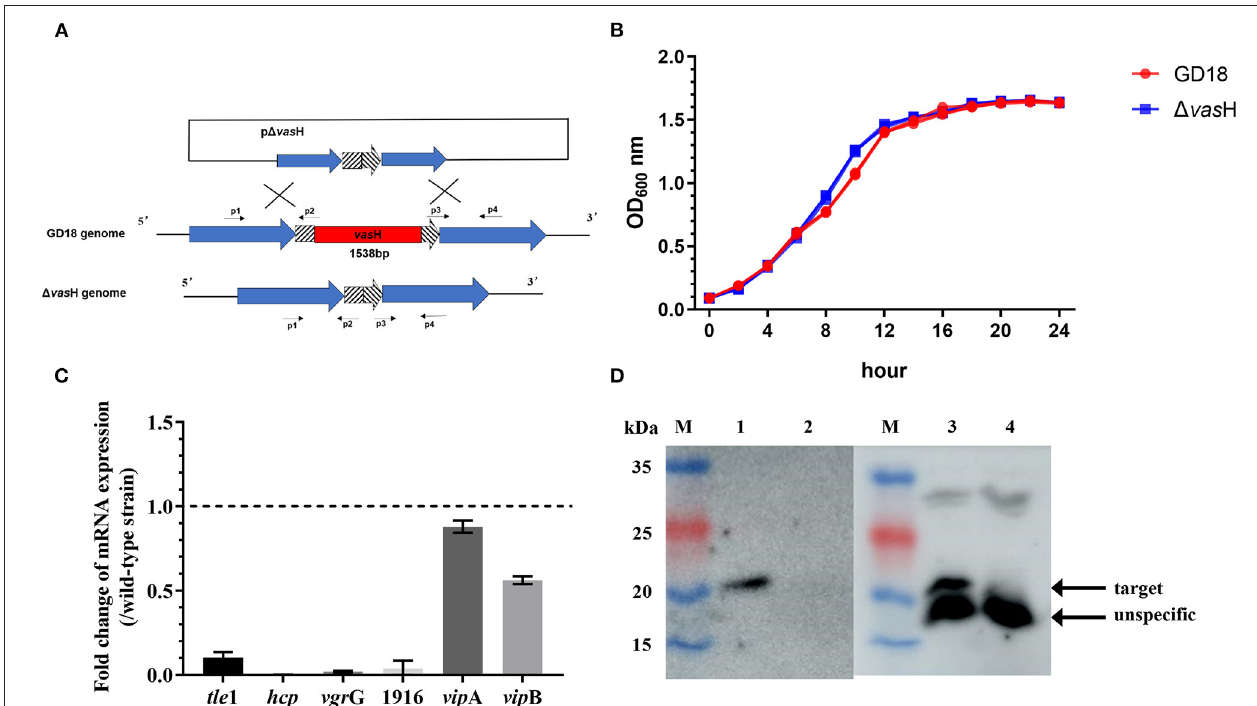
FIGURE 6 | Construction and phenotypic characterization of 1 vas H strain. (A) Construction strategy of 1 vas H by homologous recombination. (B) Growth curves in LB medium over a 24h period at 28 ◦ C. (C) Fold change of transcriptional levels of the T6SS genes in 1 vas H comparing to that in the wild-type strain at 28 ◦ C. The mRNA level of each gene was normalized to that of 16S rRNA. The data was presented as the mean ± SD of three independent experiments. (D) Hcp expression and secretion in whole-cell and supernatants of wild-type and mutant strains. Lane M, PageRuler prestained protein ladder; lane 1, GD18 supernatant; lane 2, 1 vas H supernatant; lane 3, GD18 whole-cell; lane 4, 1 vas H whole-cell. The data was from one representative experiment with at least three independent biological replicates.